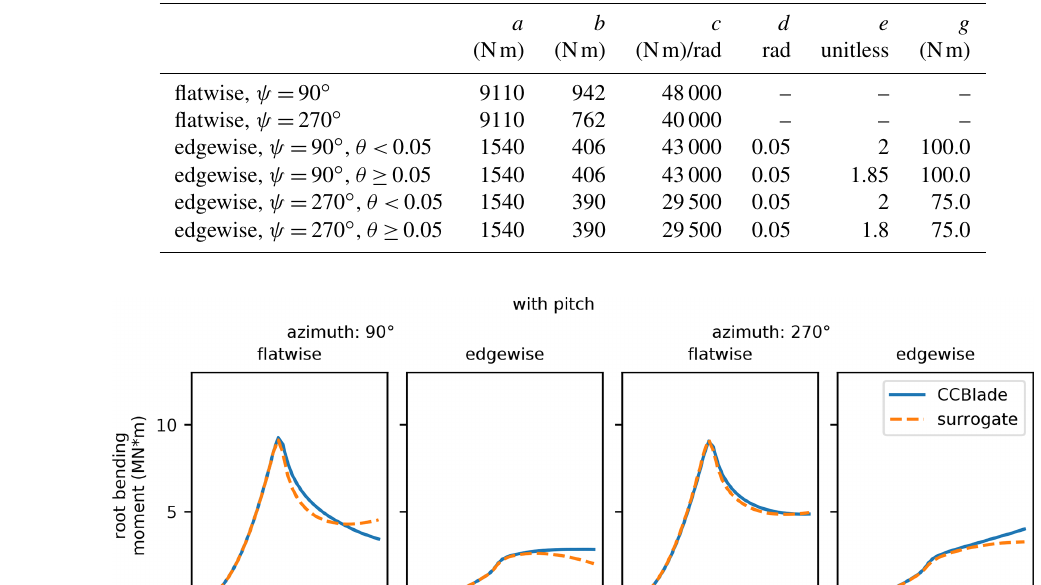
Table 1. Tuning constants for the root bending moment surrogate functions. The azimuth angle and the blade pitch are represented by ψ (in ◦ ) and θ (in radians), respectively.